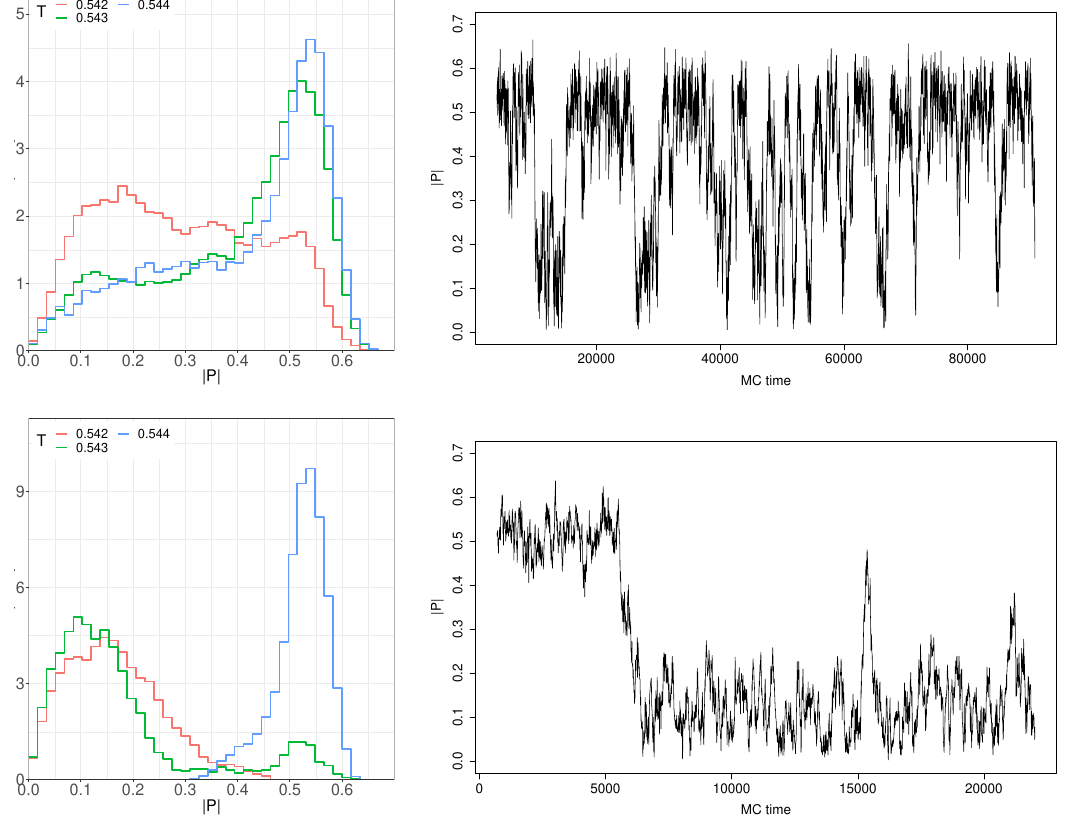
Figure 19. Full BMN model: the histogram (left) and typical Monte Carlo history (for T = 0 . 543 ) (right) of P close to the critical temperature for µ = 2 . 0 , for N = 24 , L = 12 (top) and N = 32 , L = 12 (bottom).